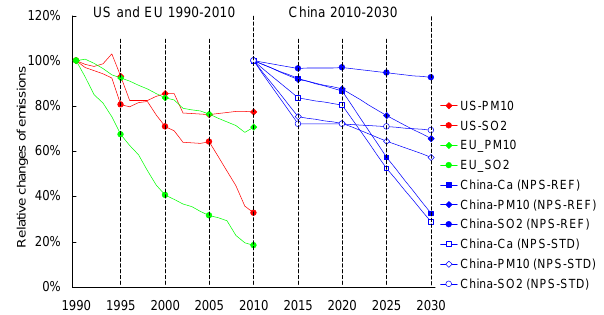
Figure 6. Relative changes of PM 10 and SO 2 emissions for the US (red) and EU (green) in 1990–2010 and those of PM 10 , Ca, and SO 2 for China in 2010–2030 under the NPS–REF (solid blue) and NPS–STD (hollow blue) scenarios in this